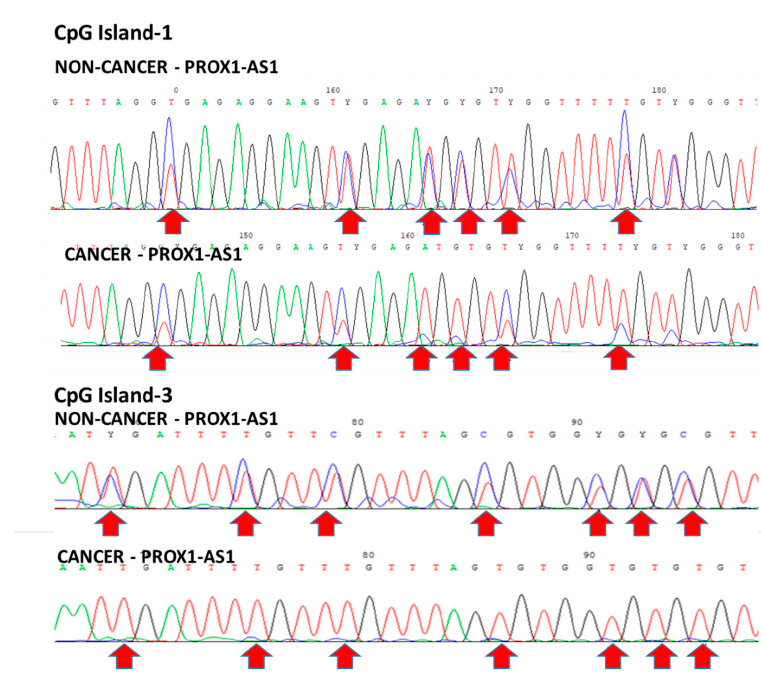
Figure 6. Bisulfite sequencing of paired non-tumor and tumor tissues. CpG island 1: Top-line— hemimethylation in NT (blue and red peaks). Bottom line—differential methylation (blue or red peaks) in some CG in T. CpG island 3—hemimethylation in NT (blue and red peaks) and demeth- ylation (only red peaks) in T.